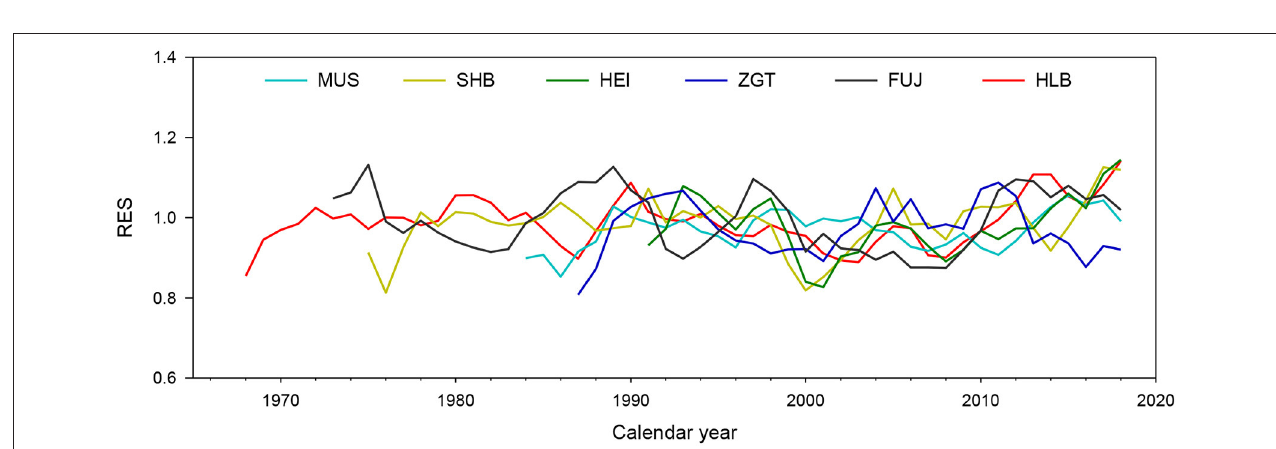
FIGURE 4 | Individual time-series and residual tree-ring width (TW) index among the Mongolian pine trees at six experimental sites.